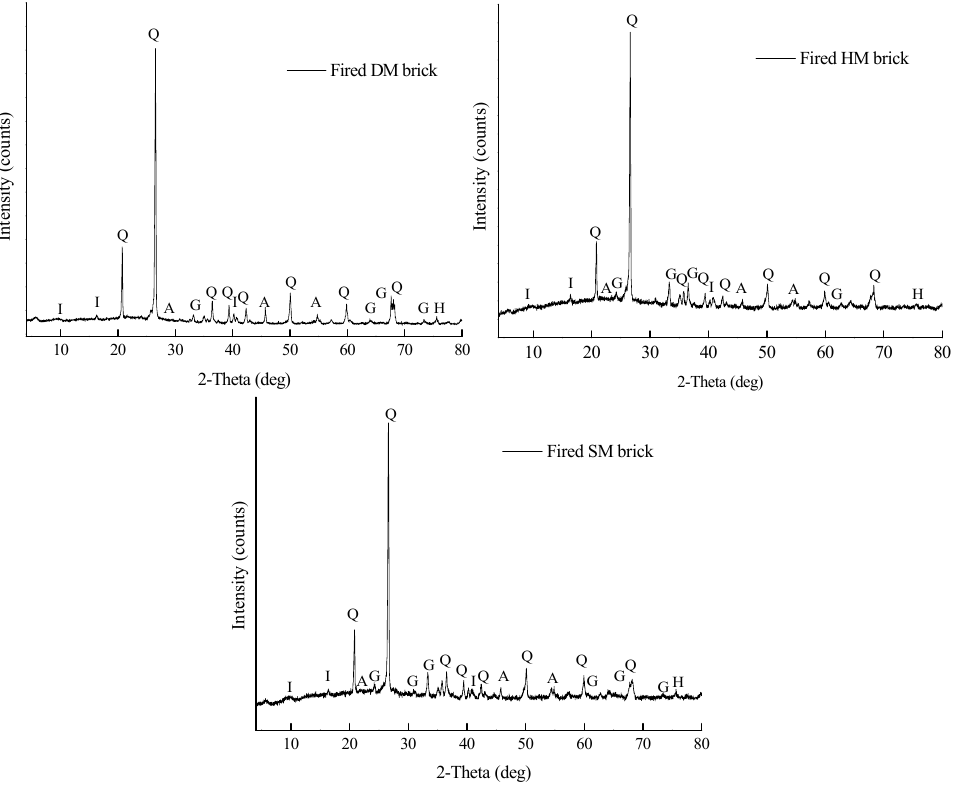
Figure 9. XRD spectrum of fired DM, HM, and SM brick specimens at 1050 °C.